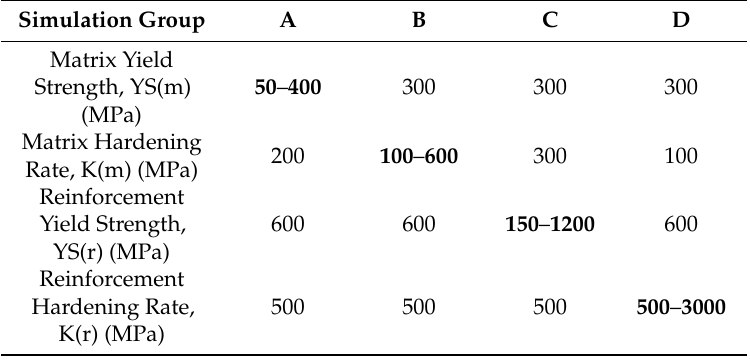
Table 1. Summary of the material parameters used in the FEM studies. Linear work-hardening was assumed for both the matrix and reinforcement. The properties of the matrix and reinforcement are identified by adding (m) and (r), respectively, after the variable